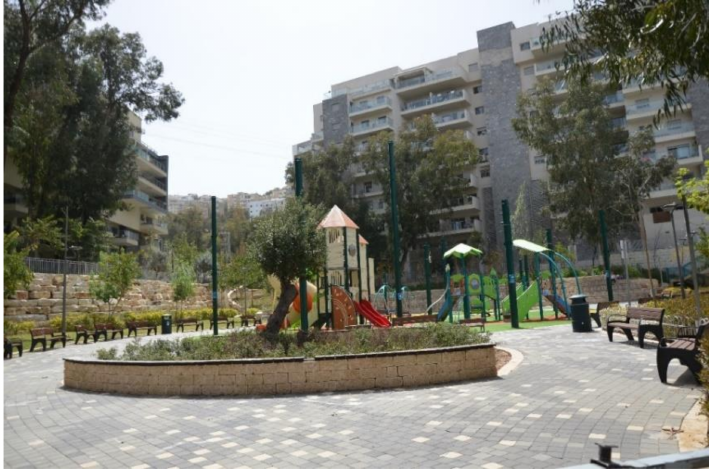
Figure 10. The open public space in the neighborhood: a single, paved and artificial space, instead of the multiple natural spaces of the past. Photograph by the authors,